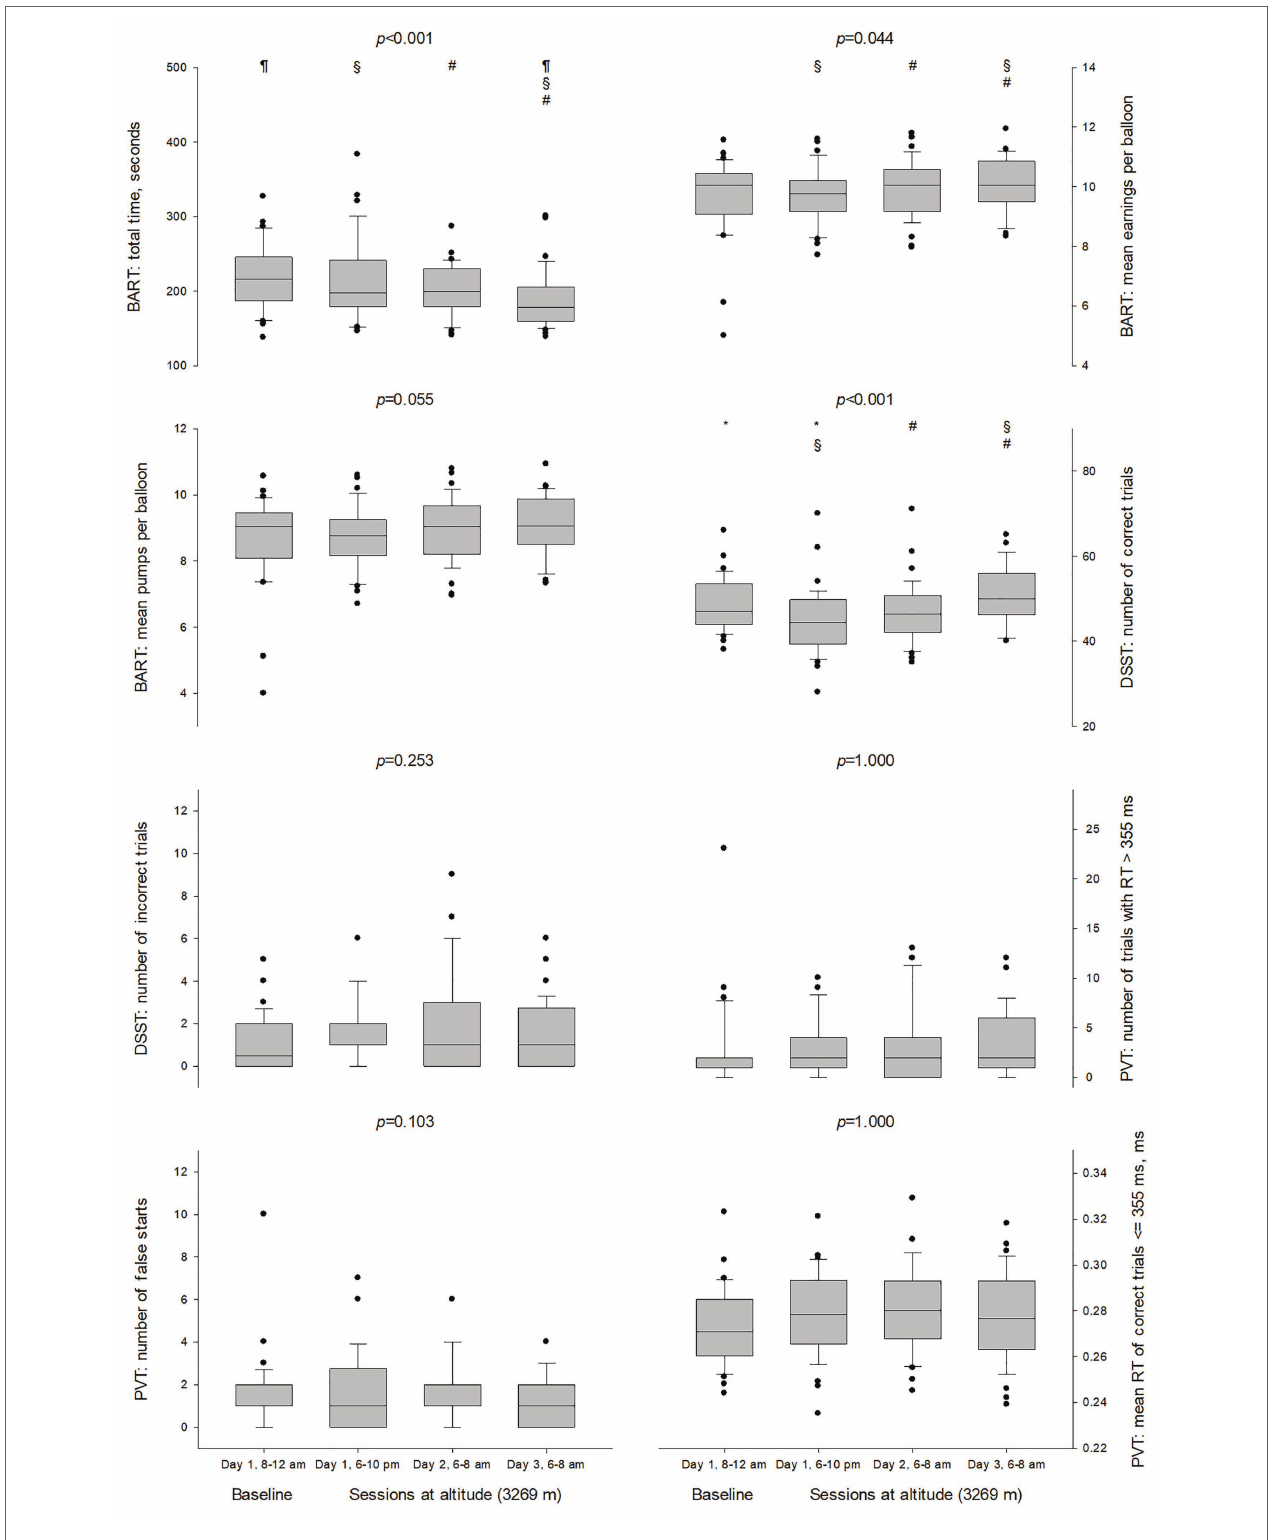
FIGURE 3 | Boxplots of cognitive test parameters at baseline and sessions at altitude (3,269 m). The p -values were calculated by means of generalized estimating equations (GEE) and adjusted by means of Holm-Bonferroni correction. Statistically significant ( p < 0.05) pairwise comparisons were denoted by the